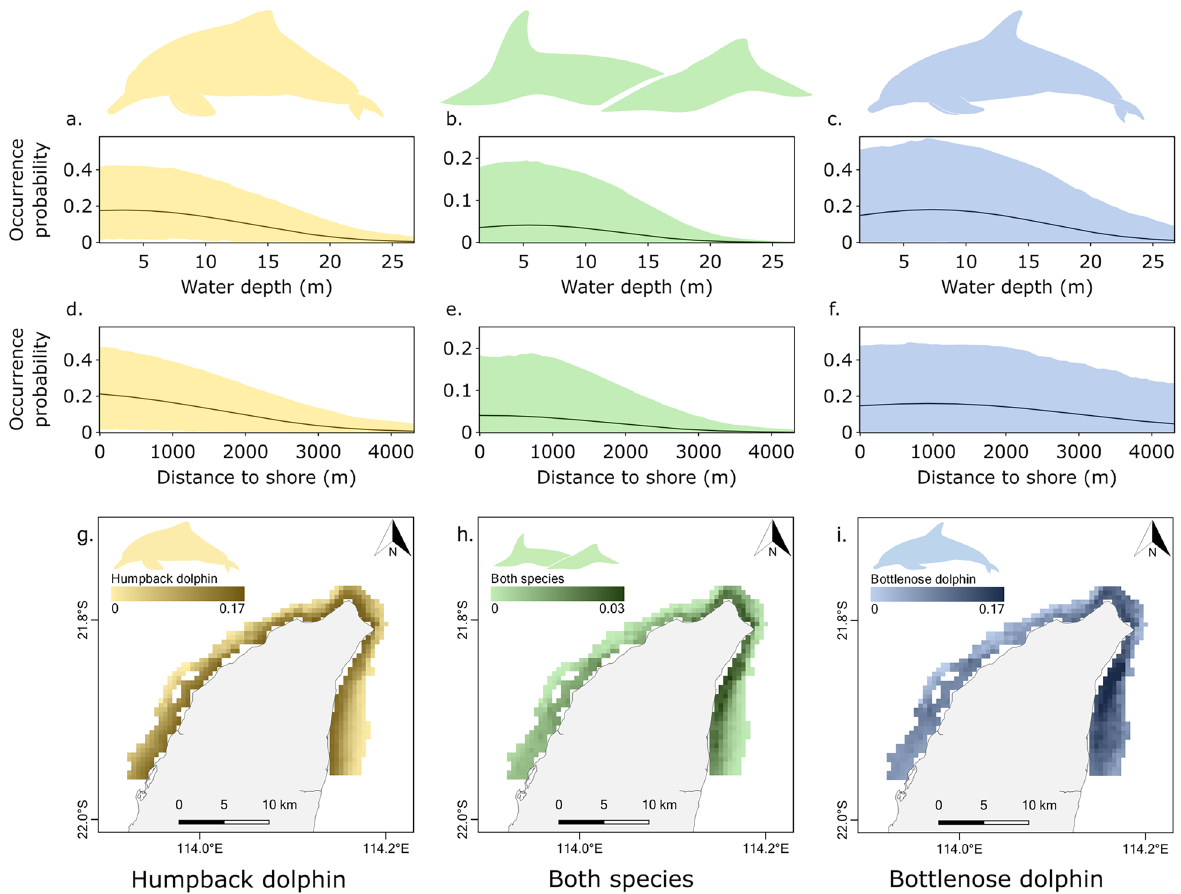
Figure 4. Results of a joint species distribution model of the occurrence of Australian humpback ( Sousa sahulensis ) and Indo-Pacific bottlenose dolphins ( Tursiops aduncus ), around the North West Cape, Western Australia. The three columns illustrate the predicted occurrence probability of humpback dolphins, the predicted co-occurrence probability of the two species, and the predicted occurrence probability of bottlenose dolphins relative to water depth ( a , b , and c ) and distance to shore ( d , e , and f ), as well as across 540 grids of 500 × 500 m ( g , h , and i ). In the first ( a , b , and c ) and second rows ( d , e , and f ), the line represents the mean and the shaded area the 95% credibility interval. Occurrence probabilities for humpback and bottlenose dolphins were calculated while normalising the remaining variables to their mean values. Co-occurrence probabilities were calculated by multiplying the corresponding single-species occurrence